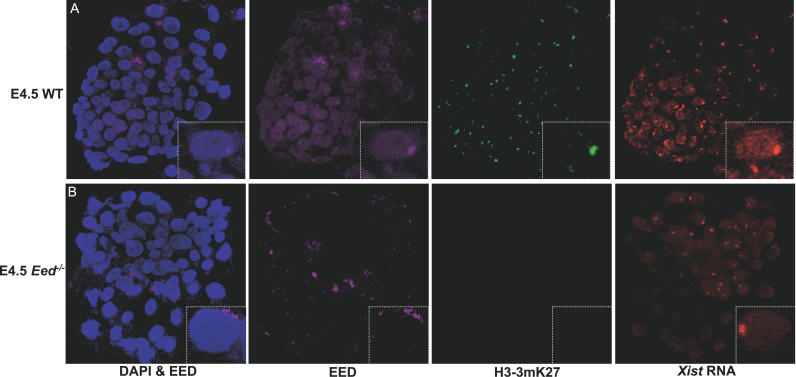
Absence of H3-3mK27 in Eed
−/− Embryos at E4.5(A) IF-FISH detection shows Xi enrichment of EED protein and H3-3mK27 in a WT E4.5 embryo. The Xi is marked by Xist RNA coating, detected by FISH. DAPI staining detects nuclei.(B) An E4.5 female embryo that is devoid of EED and H3-3mK27. The EED antibody staining seen is background and does not overlap with the Xi, as denoted by Xist RNA coating.